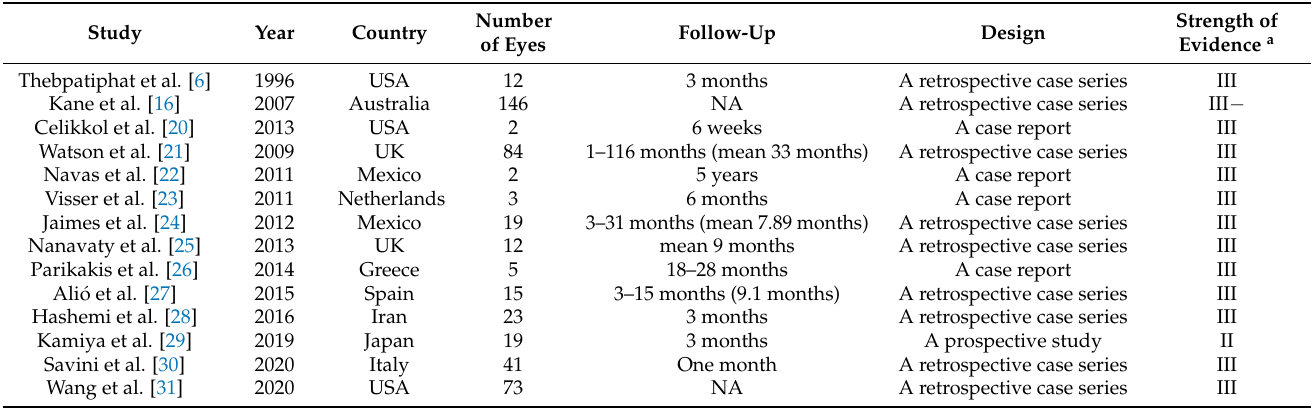
Table 1. Summary of